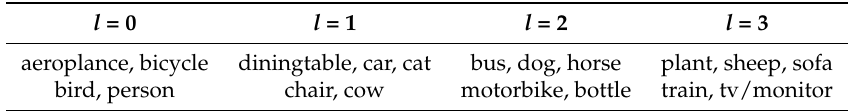
Table 1. Classes for each fold of PASCAL-5i. To ensure the class disjoint { l train } ∩ { l test } = ∅ , we split the dataset into four parts. We used three of them for training and the remainder for